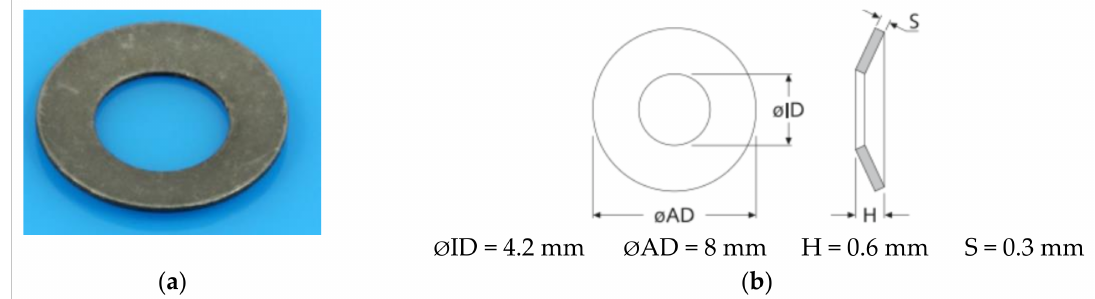
Figure 2. Spring washer, disc spring, DIN 2093 B. ( a ) image of spring washer; ( b ) the dimensions of the spring